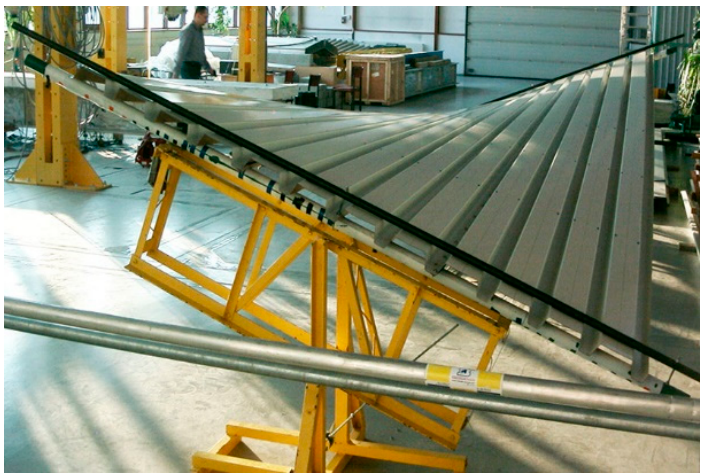
Figure 1. Transformed folded shell sheeting twisted with two skew directrices.